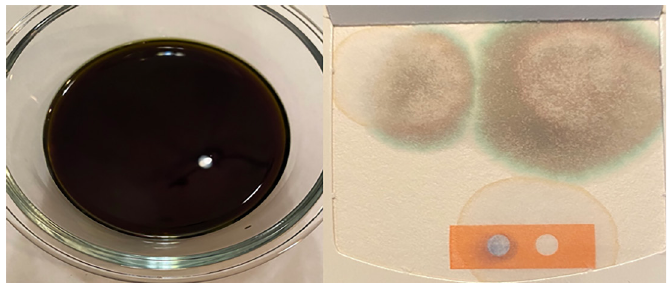
Image 2. Weak solution of artifical food coloring emulsified with water (left). Sample of this mixture tested on a guaiac fecal occult blood test card